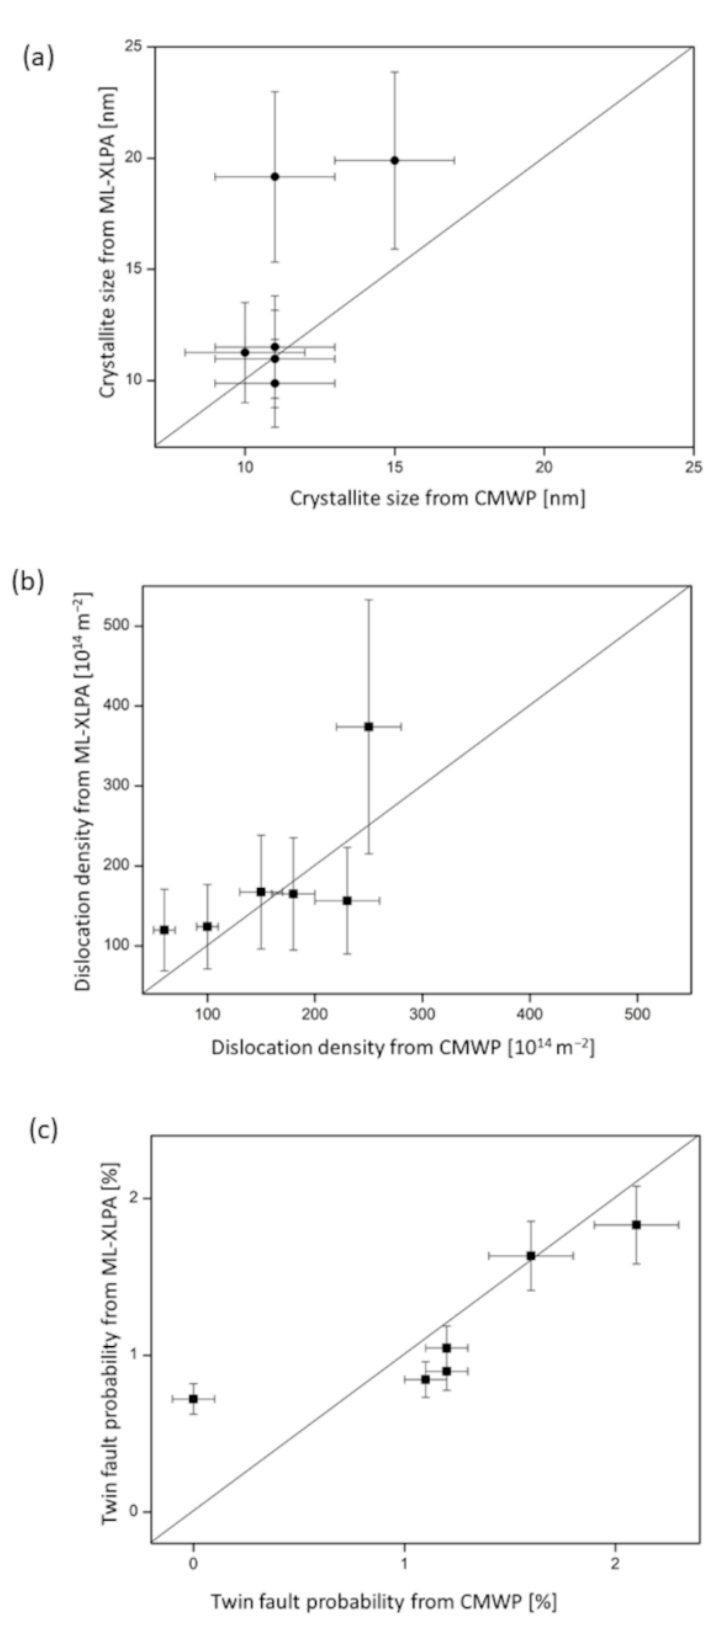
Figure 10. The crystallite size ( a ), dislocation density ( b ) and twin fault probability ( c ) obtained by ML-XLPA versus the values determined by the CMWP fitting method at the six points shown in Figure 1.